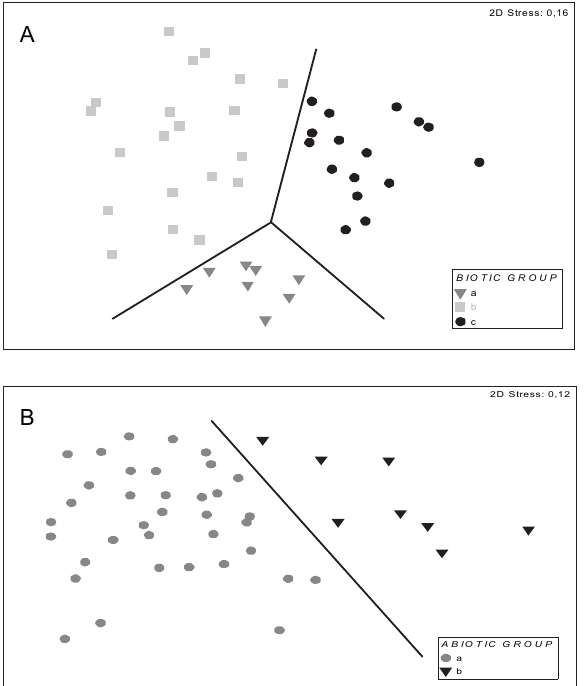
Fig . 8. – multi-dimensional Scaling (mdS) of a) Pseudo-nitzschia abundances, and B) abiotic data. Statistically different groups are